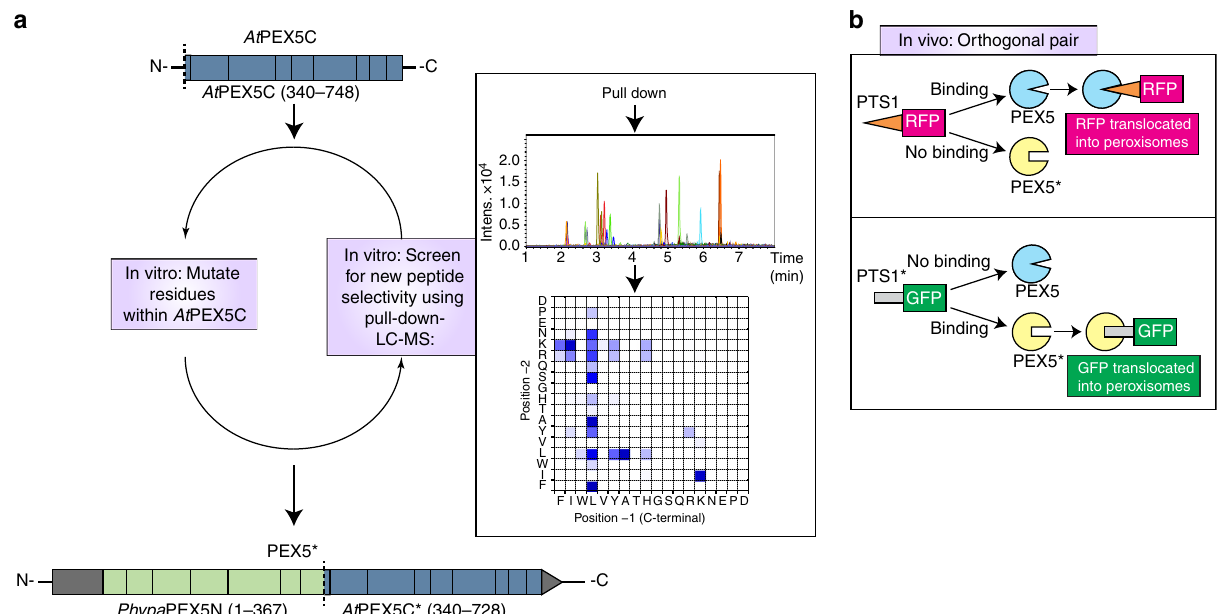
Fig. 1 Strategy for the development of an orthogonal PEX5:PTS1-like interaction. a The C-terminal domain of At PEX5 ( At PEX5C) was mutated and screened in vitro against a library of peptides to identify binding of non-PTS1 sequences. Once an orthogonal pair of peptide (PTS1*) and protein (PEX5*) was identi fi ed, the mutant At PEX5C* sequence was then fused to Phypa PEX5N to create a hybrid full-length receptor with altered speci fi city suitable for in vivo experiments in the moss P. patens (Phypa) . b The intracellular localization of fl uorescent proteins appended with either a PTS1 or PTS1* sequence was then used to determine the orthogonality of import in